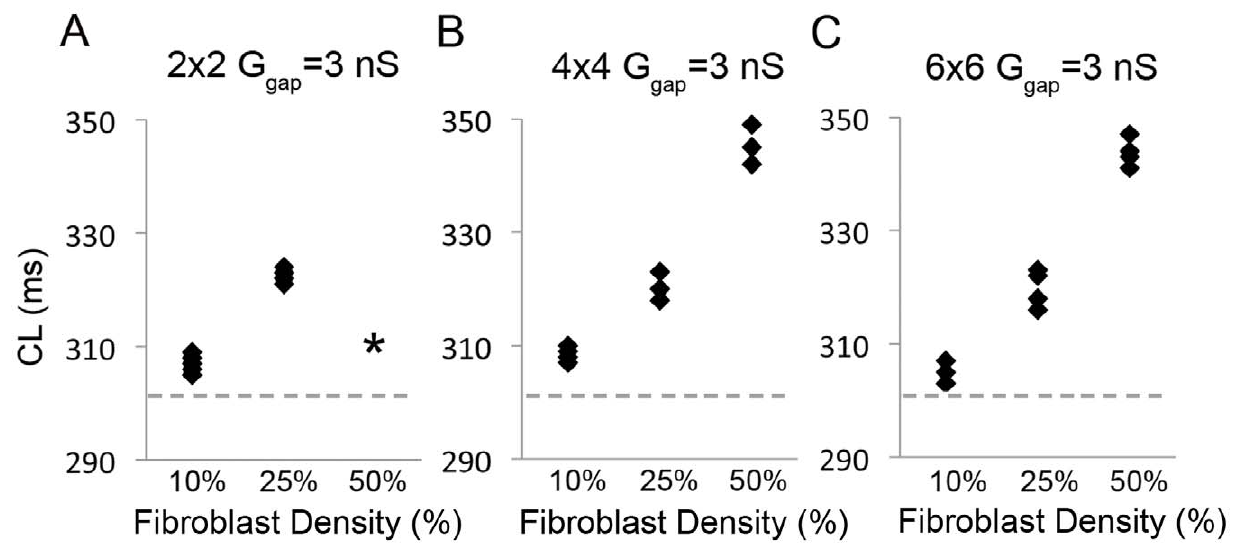
Figure 6. Excitation frequency decreases as fibroblasts density increases for all fibroblast island sizes (A - 2 6 2, B - 4 6 4, C - 6 6 6). The density (10%, 25% or 50%) for 5 fibroblast distributions (black diamonds) with G gap =3 nS. The dashed gray line denotes the CL control value (302 ms).